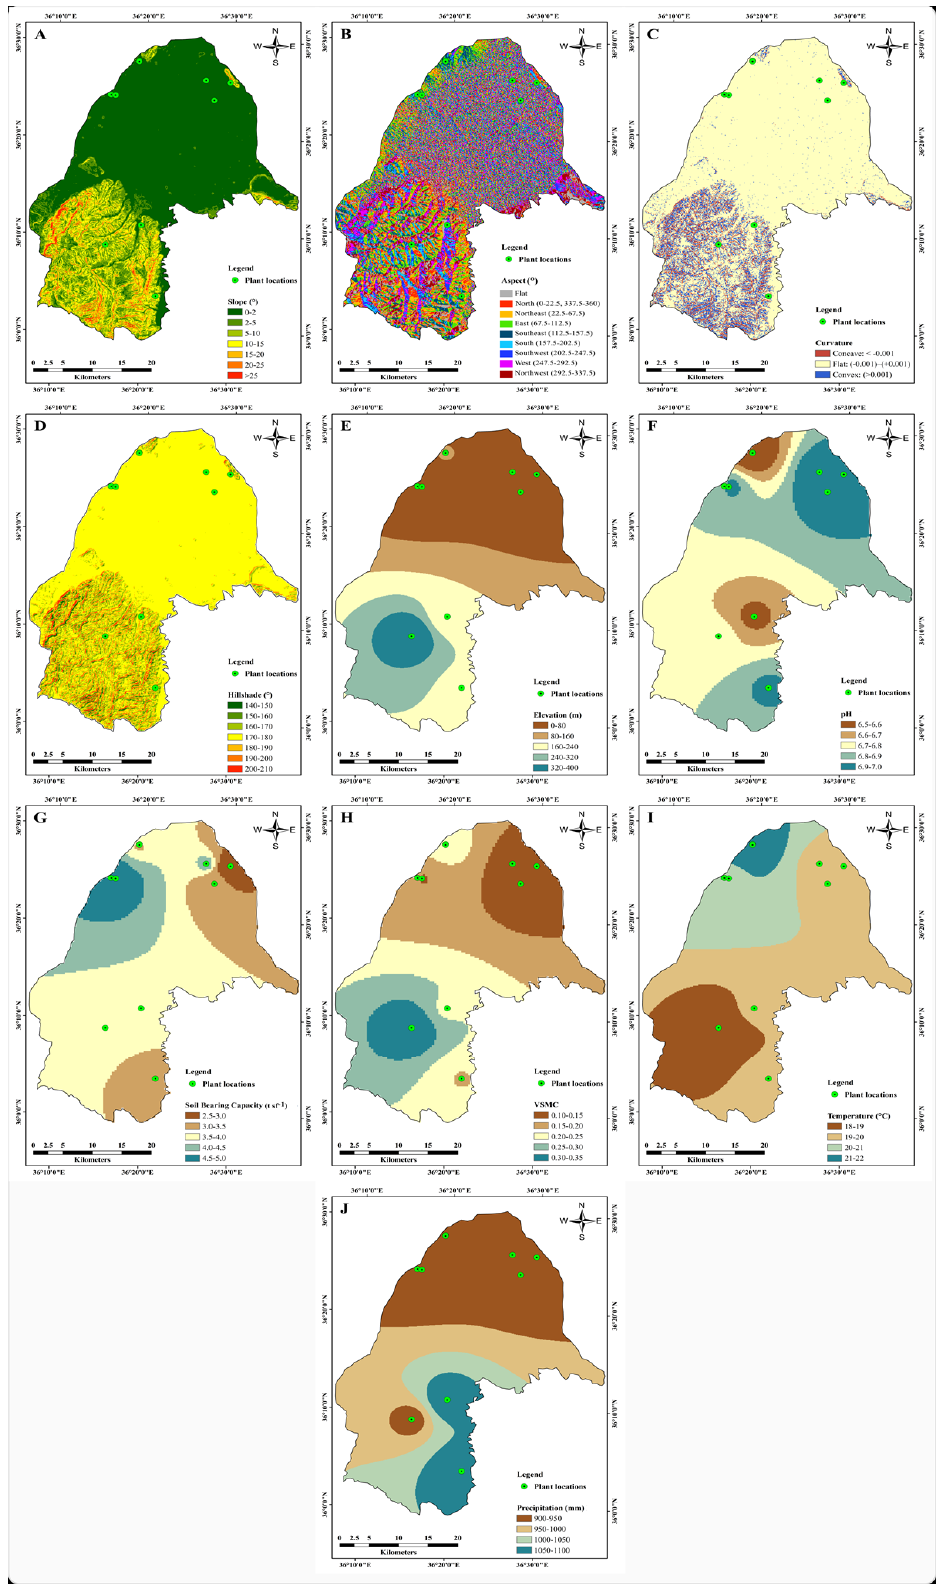
Figure 5. Thematic maps of the study area: ( A ) slope, ( B ) aspect, ( C ) curvature, ( D ) hillshade, ( E ) elevation, ( F ) pH, ( G ) soil bearing capacity, ( H ) VSMC, ( I ) temperature, and ( J )